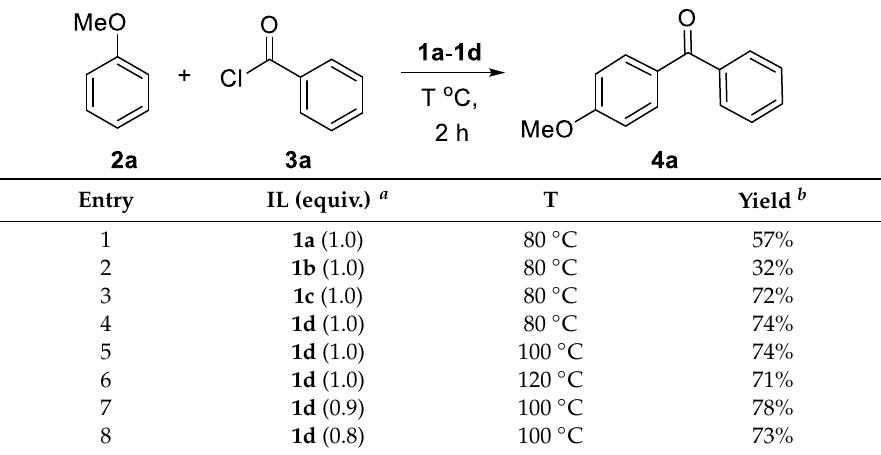
Table 1. Optimized condition of Friedel–Crafts acylation.